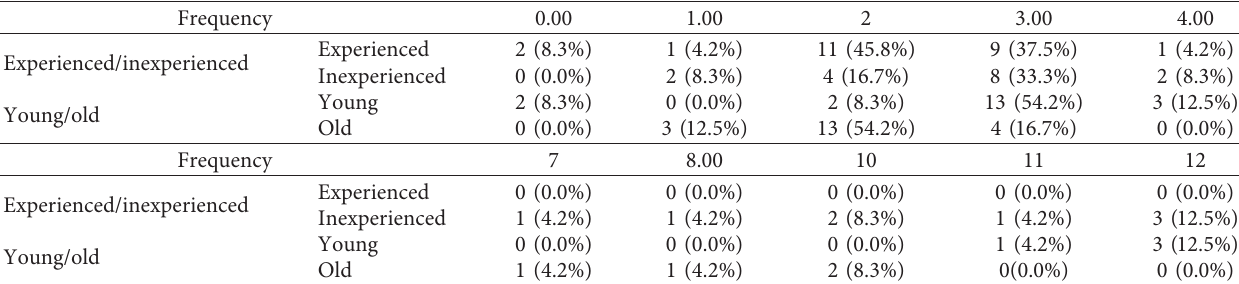
Table 4: Descriptive statistics of frequency and percentage of steering wheel correction frequency among different ages and experience levels in the T1 task.